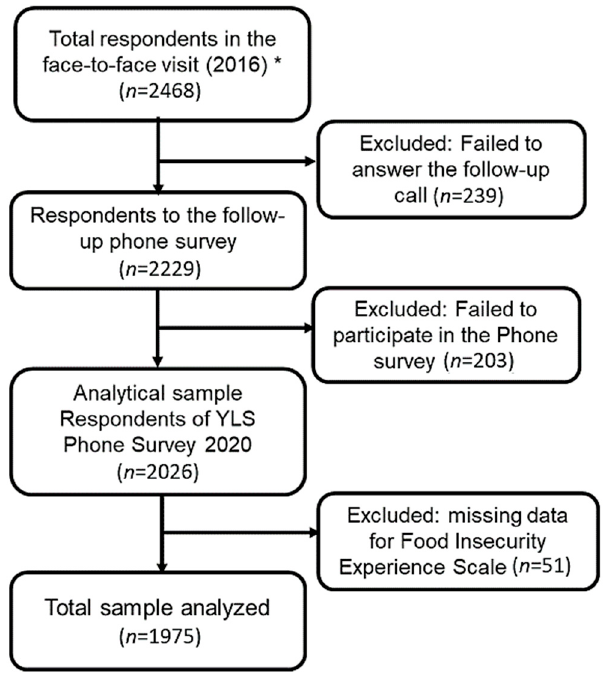
Figure 1. Flow chart of the analytical sample of participant of the Young Live Study in Peru (YLS). * Includes Peruvian participants from the younger (18–19 year.) and older cohort (24–27 year.) combined. Table 1. Individual characteristics of the YLS participant by food insecurity